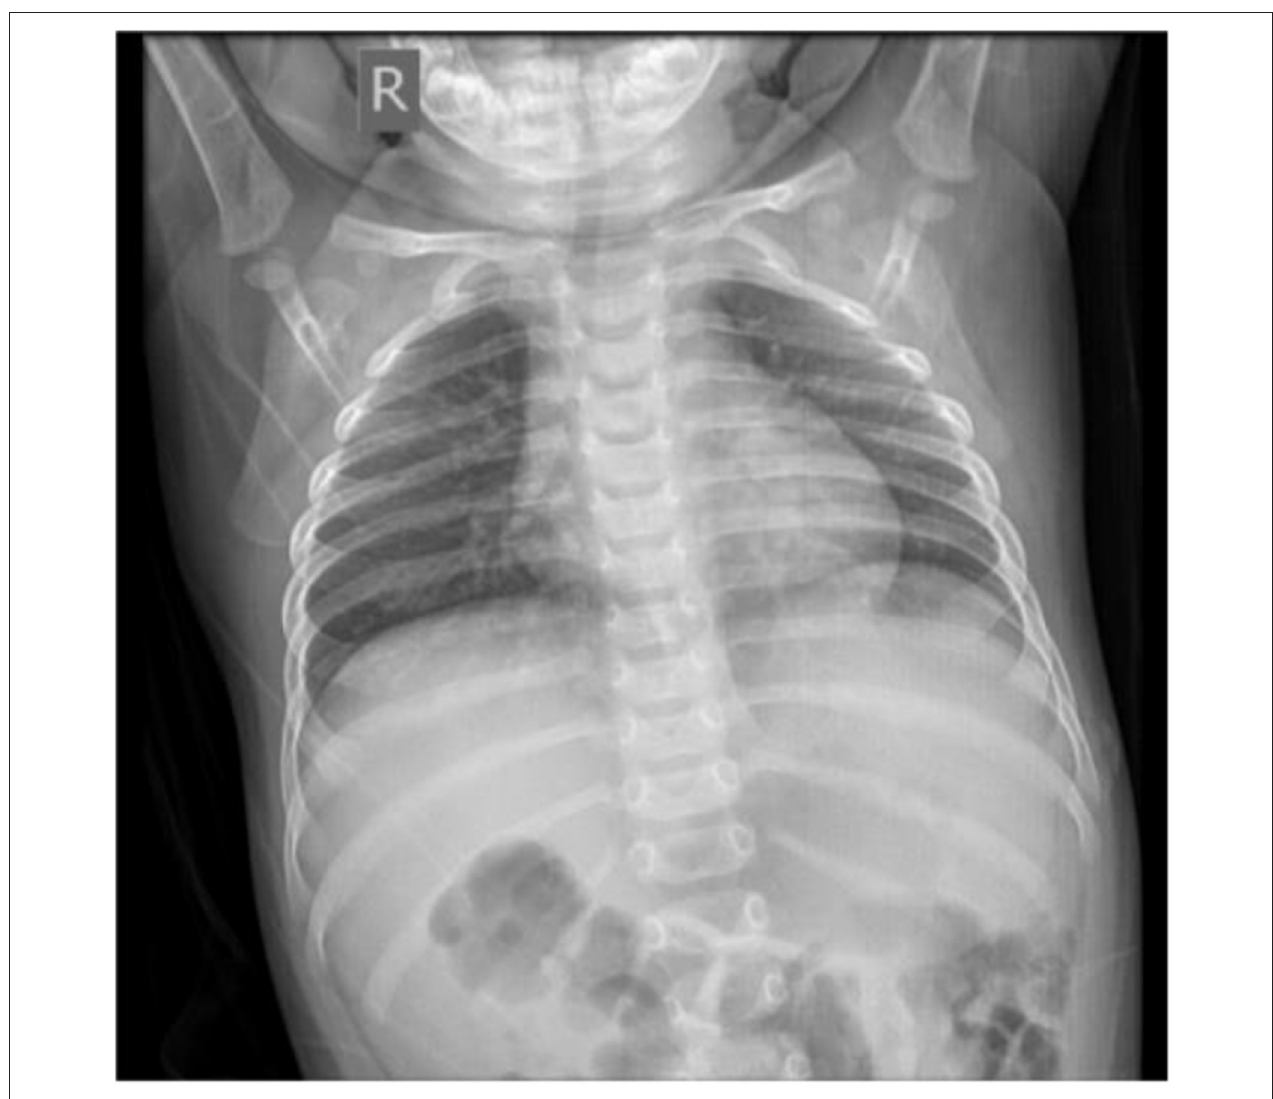
FIGURE 6 | Chest X-ray after